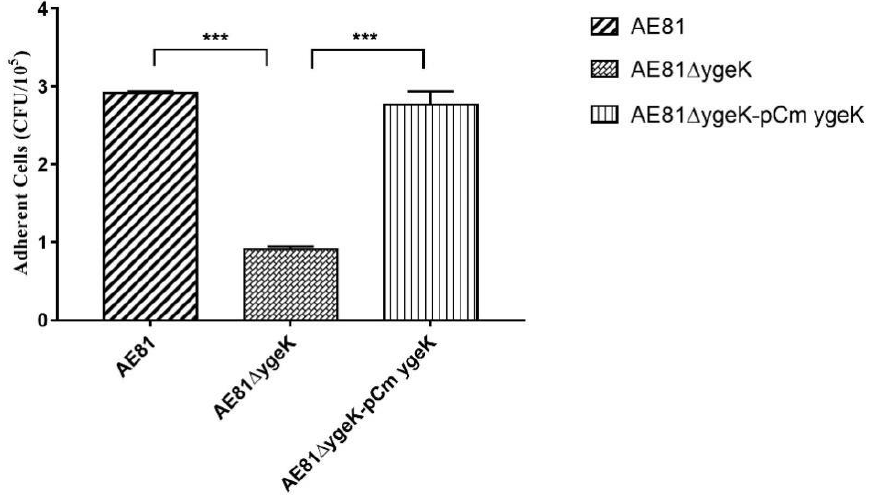
Figure 4. Bacterial adhesion assay with avian DF-1. Inactivation of YgeK decreased adhesion to avian DF-1 cells compared with wild-type AE81 and complemented AE81 ∆ ygeK -pCm ygeK strains. Values are the average of three independent experiments. Error bars indicate standard deviation. *** p <